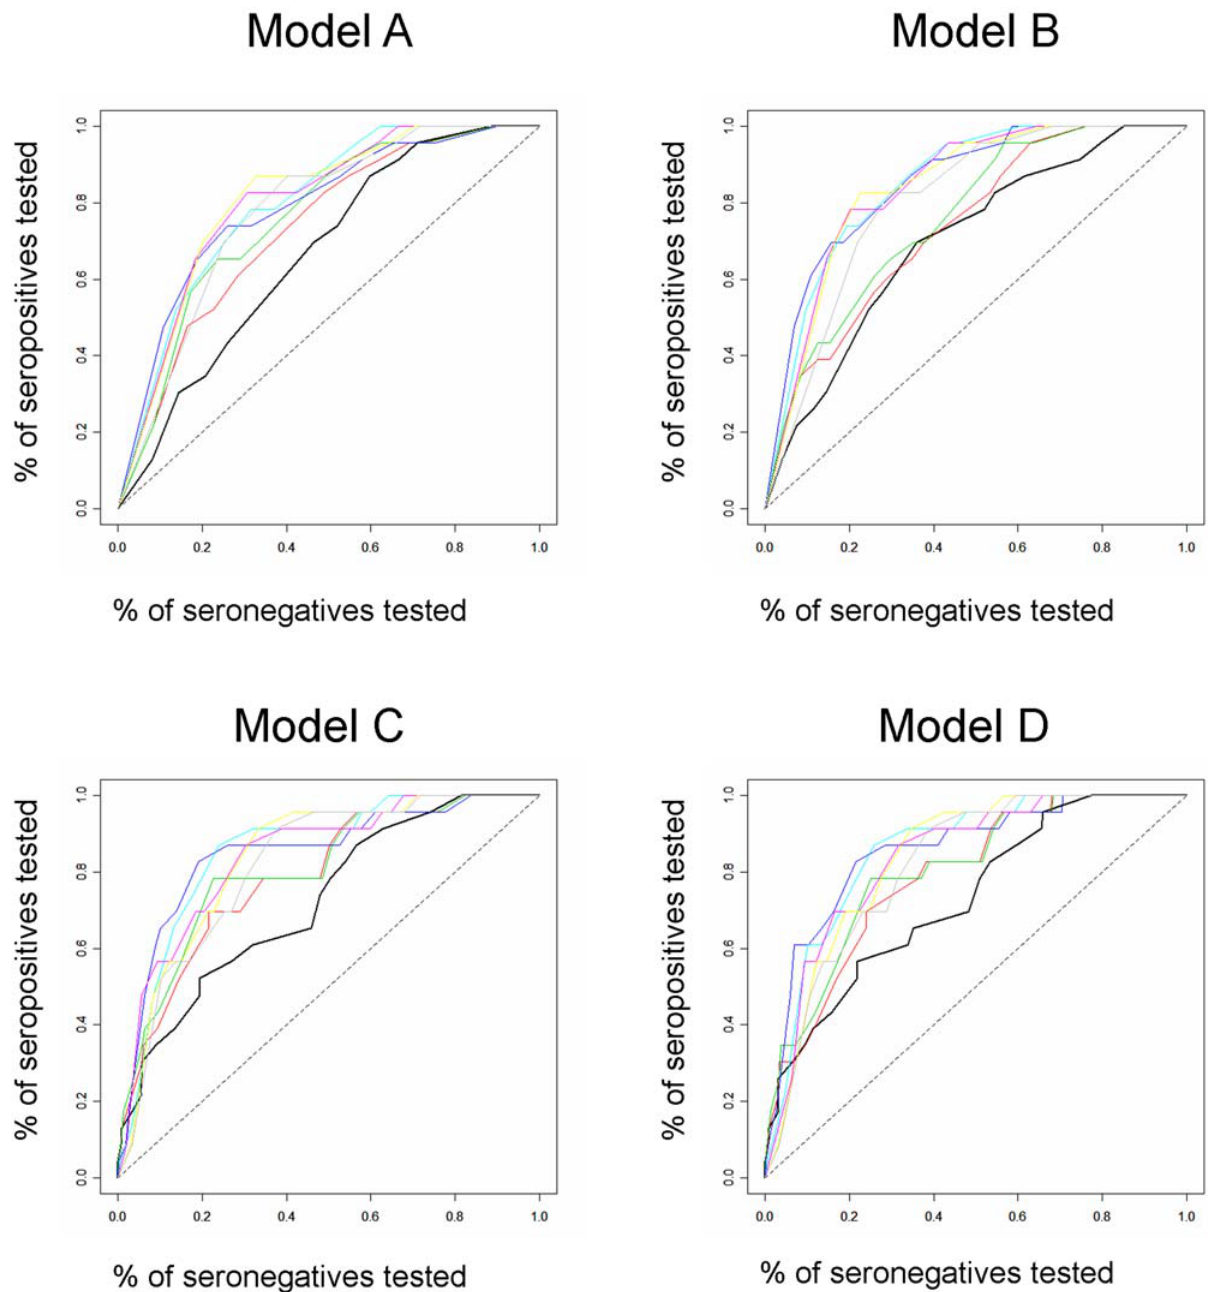
Figure 2. Receiver-operator curves from multivariate models predicting T.cruzi infection in children aged 18 years and younger in the community of Guadalupe, Arequipa, Peru, 2005. Model A includes information on age only, Model B includes data on age and vector presence, Model C includes age and domestic vector density, and Model D includes information on age, domestic vector density, and the presence of domestic T. cruzi -infected vectors (see Table 2). For each graph non-spatial ROC curves are in black. ROC curves for two-stage testing algorithms are in color (red=10 meter radius, green=20 m, blue=30 m, teal=40 m, magenta=50 m, yellow=60 m, grey=70 m). Seropostives are positive by two tests (ELISA and IFA), seronegatives are negative by